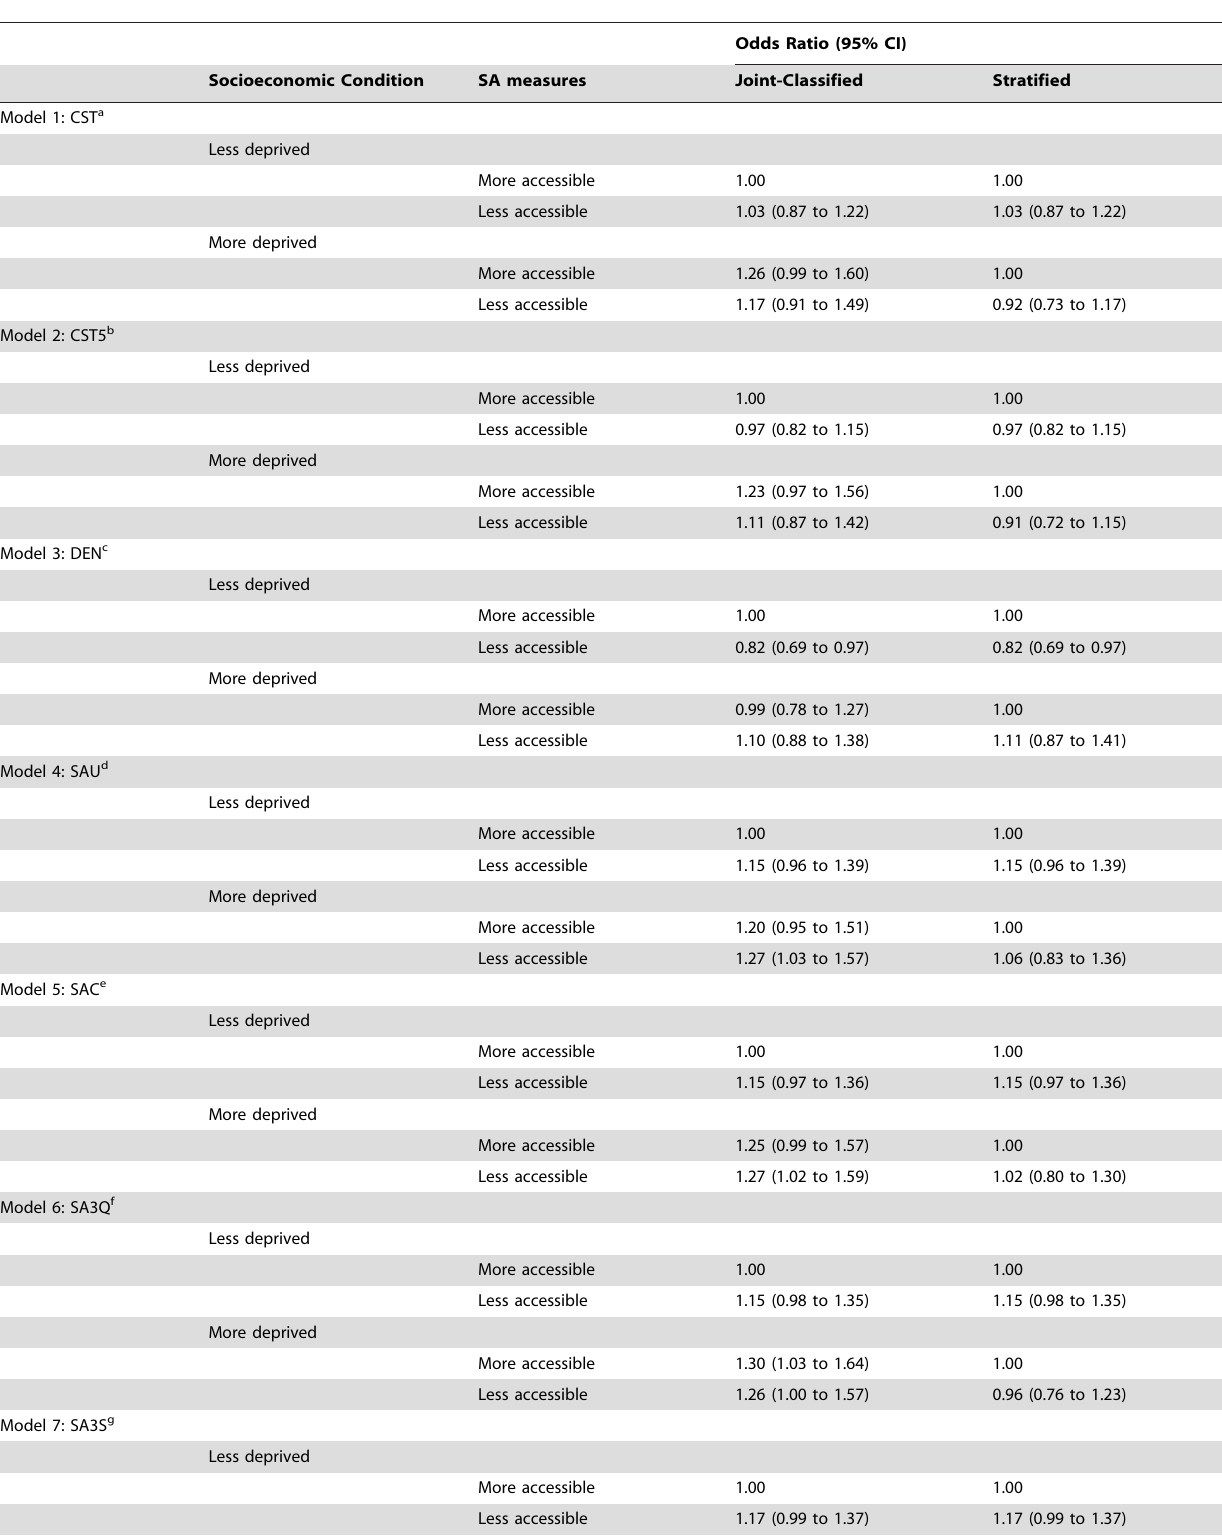
Table 7. Combined effect of block group spatial accessibility to mammography service and socioeconomic (SES) deprivation on risk of late-stage breast